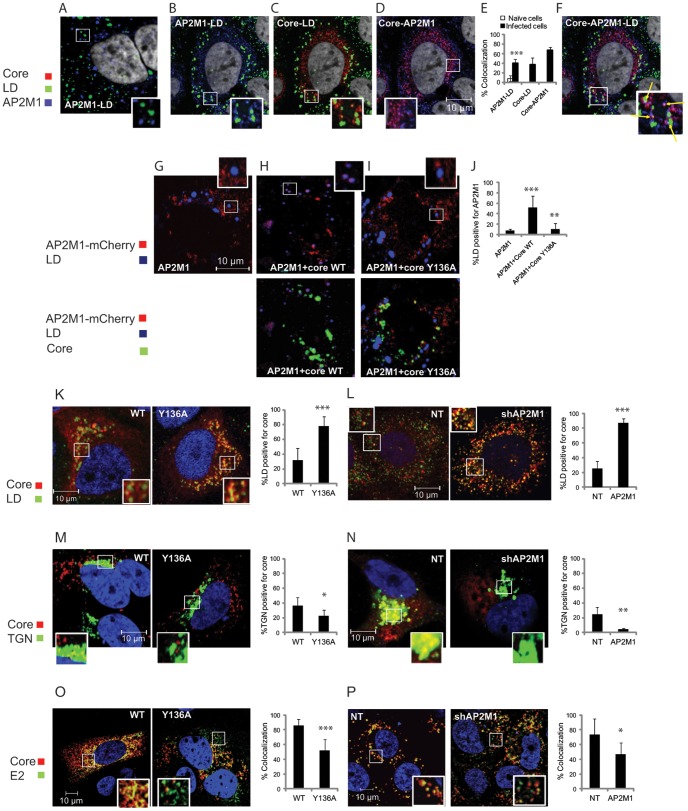
Disruption of core-AP2M1 binding abolishes recruitment of AP2M1 to LD and alters the sub-cellular localization of core and its colocalization with E2.Quantitative confocal immunofluorescence (IF) analysis of the sub-cellular localization of core and AP2M1 and core-E2 colocalization in Huh-7.5 cells. A. A representative merged image of endogenous AP2M1 (blue) and the LD marker, Bodipy (green), in naive Huh-7.5 cells. B–D. Merged images of Huh-7.5 cells infected with J6/JFH HCV stained for core (red), the LD marker, Bodipy (green), and AP2M1 (blue). E. Percent colocalization of the indicated signals in naive (white) or infected (black) cells by a quantitative colocalization analysis of A–D. F. A four channel merged image. The yellow arrows in the inset indicate colocalization of core and AP2M1 to LD. G–J. Representative merged images and quantitative colocalization analysis of AP2M1 (red) and the lipid marker, LipidTOX (blue), in Huh-7.5 cells transfected with plasmids expressing AP2M1-mCherry alone (G) or AP2M1-mCherry with WT core (H) or core Y136A mutant (I). Core expression (green) in the cells shown in panels H and I is demonstrated in the respective bottom panels. (K–P) Representative merged images and quantitative colocalization analysis of core (red) and: K. Bodipy (green), demonstrating increased localization of core to LD in Huh-7.5 cells electroporated with J6/JFH HCV RNA harboring the Y136A core mutation (right panel) compared with WT core (left panel). L. Bodipy (green) in control (NT) cells (left panel) or AP2M1 depleted (right panel) Huh-7.5 electroporated with J6/JFH HCV RNA, showing a dramatic localization of core to LD in AP2M1 depleted cells. M. TGN46 (green), demonstrating decreased localization of core to TGN in Huh-7.5 cells electroporated with J6/JFH RNA harboring the Y136A core mutation (right panel) compared with WT core (left panel). N. TGN46 (green) in control (NT) cells (left panel) or AP2M1 depleted (right panel) Huh-7.5 electroporated with J6/JFH HCV RNA, showing decreased localization of core to TGN in AP2M1 depleted cells. O. E2 (green), demonstrating decreased colocalization of core and E2 in Huh-7.5 cells electroporated with J6/JFH RNA harboring the Y136A core mutation (right panel) compared with WT core (left panel). P. E2 (green) in control (NT) cells (left panel) or AP2M1 depleted (right panel) Huh-7.5 electroporated with J6/JFH HCV RNA, showing decreased colocalization of core and E2 in AP2M1 depleted cells. Representative images at ×60 magnification are shown. Graphs represent quantitative colocalization analysis of Z stacks using Manders' coefficients. Values indicate mean M2 values represented as percent colocalization (the fraction of green intensity that coincides with red intensity or in the case of Figures G–I, the fraction of blue intensity that coincides with red intensity) ± s.d. (error bars); n = 10–15. * p<0.05, ** p<0.01, *** p<0.001.